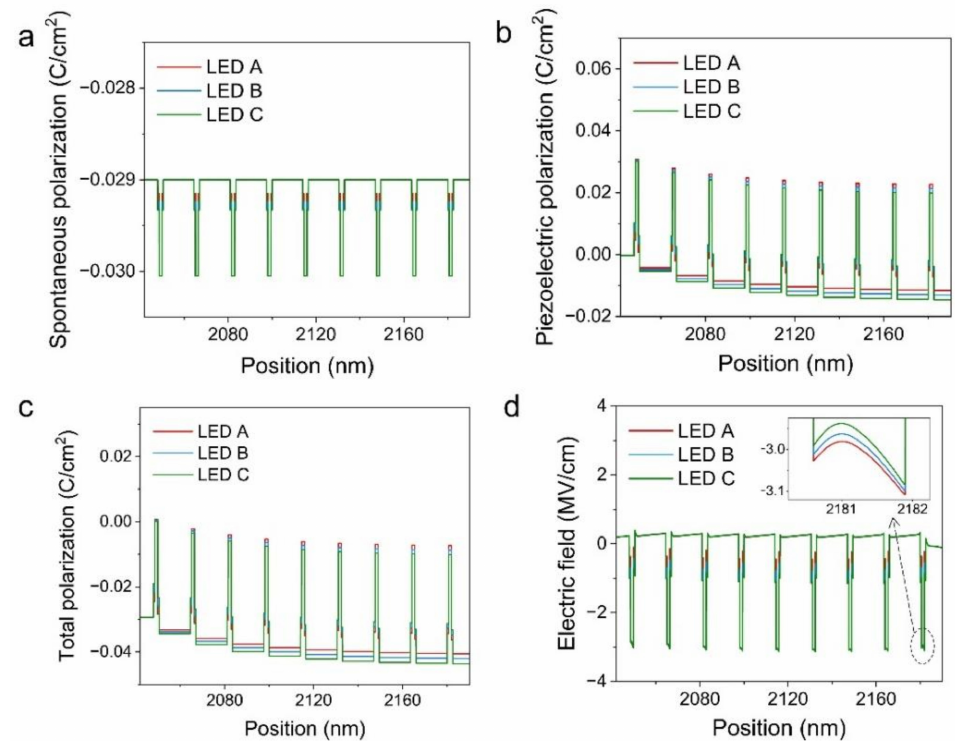
Figure 5. ( a ) Simulated spontaneous polarization fields for LEDs. ( b ) Simulated piezoelectric polar- ization fields. ( c ) Simulated total polarization fields for LEDs. ( d ) Simulated electric fields for LEDs. The inset in ( d ) shows the enlarged fragment of electric fields in the QW closest to p-side.